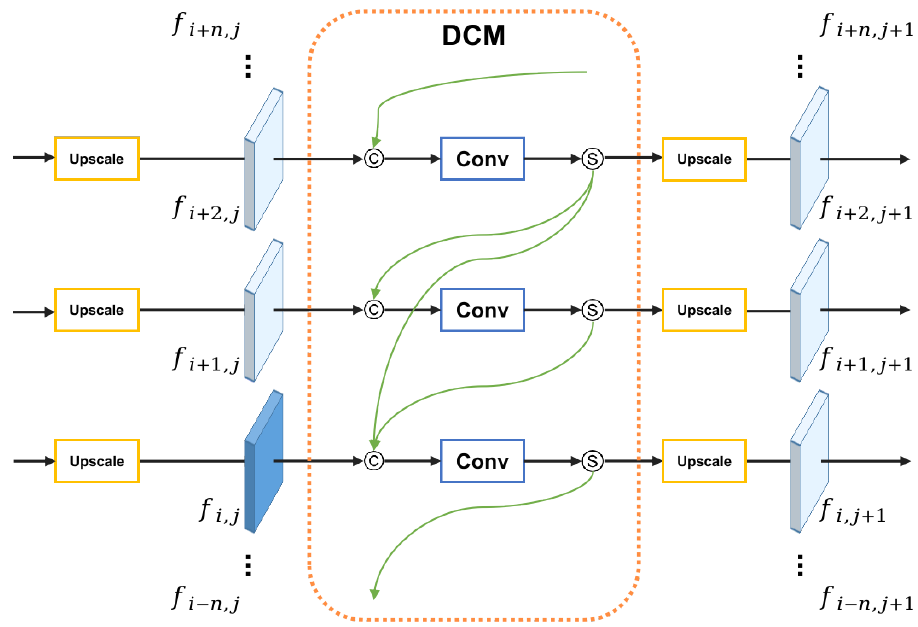
Figure 3. The overview of our presented dense connection module (DCM), where the symbols © and (cid:115) indicate concatenation and sigmoid activation,